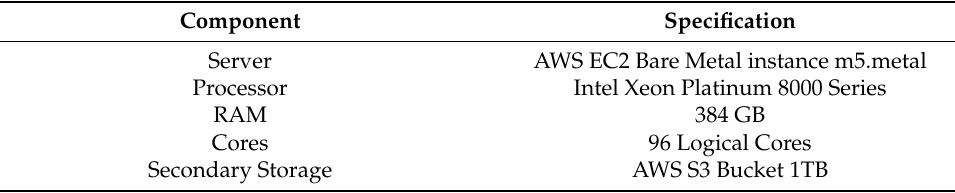
Table 1. AWS EC2 Bare Metal instance specifications for CML experiments.